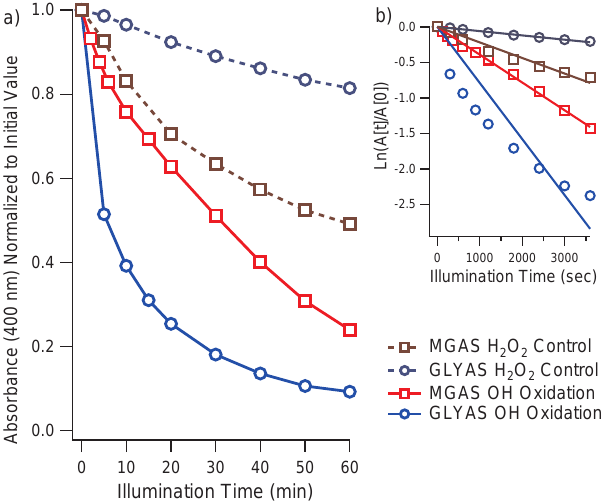
Figure 4. Time profiles of absorbance at 400 nm during OH oxi- dation (solid lines) and H 2 O 2 control (dashed lines) experiments. Results for both the GLYAS (blue traces) and MGAS (red traces) solutions are shown. The decay profiles of absorbance at 400nm normalized to the initial value at t = 0 are shown in (a) , while their corresponding first-order decay plots are shown in (b) .